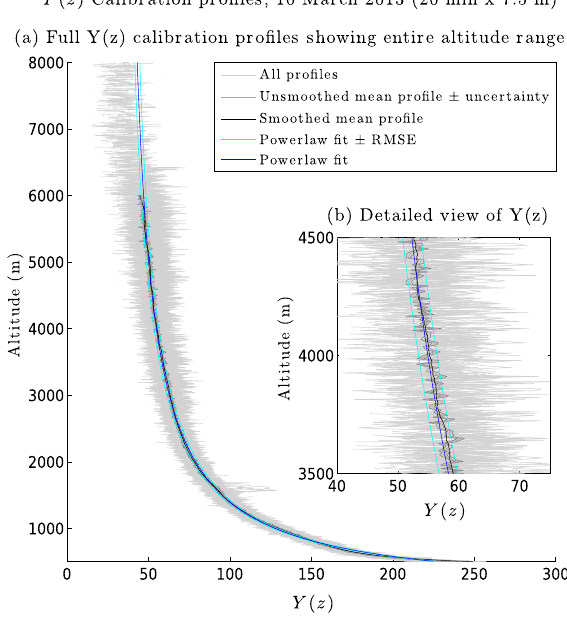
Figure 5. (a) The Y(z) calibration values from 10 March 2013 with the various fits to the night’s measurements. (b) Magnified portion of the plot on the left to show differences between the